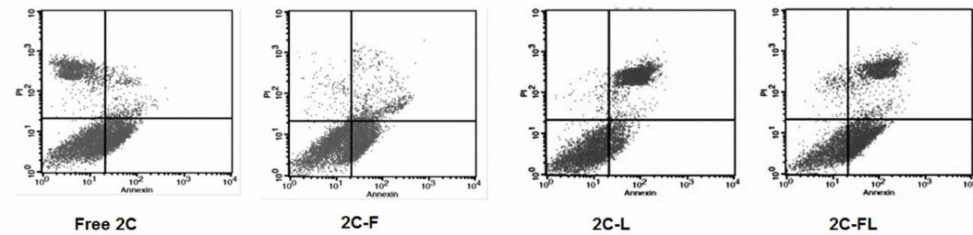
Figure 6. In vitro antifungal activity of 2C-encapsulated formulations against C. albicans using annexin V-FITC staining. Cell apoptosis was measured in fungal cells after exposing them to free 2C, 2C-F, 2C-L, and 2C-FL. The upper left quadrant of the flow cytometry density plot represents the necrotic cells (annexin − propidium iodide (PI) + ), the upper right quadrant represents late apoptotic cells (annexin + PI + ), the lower right quadrant represents early apoptotic cells (annexin + PI + ), and the lower left quadrant represents viable cells (annexin + PI −